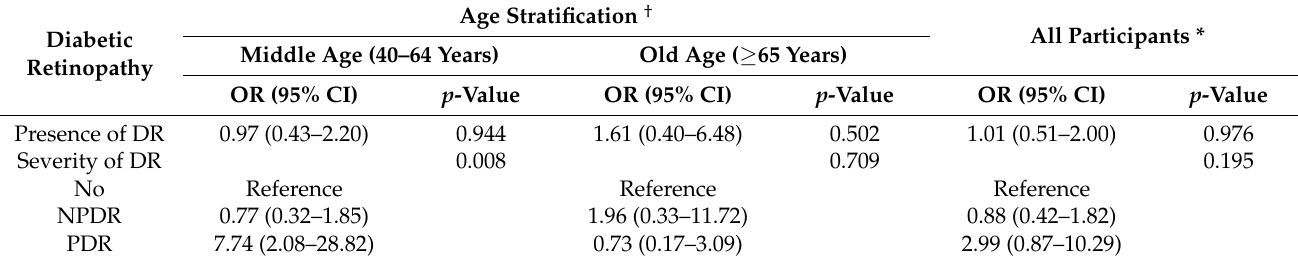
Table 4. Multivariate logistic regression analyses for the association between hearing loss and diabetic retinopathy after adjusting for all potential confounding